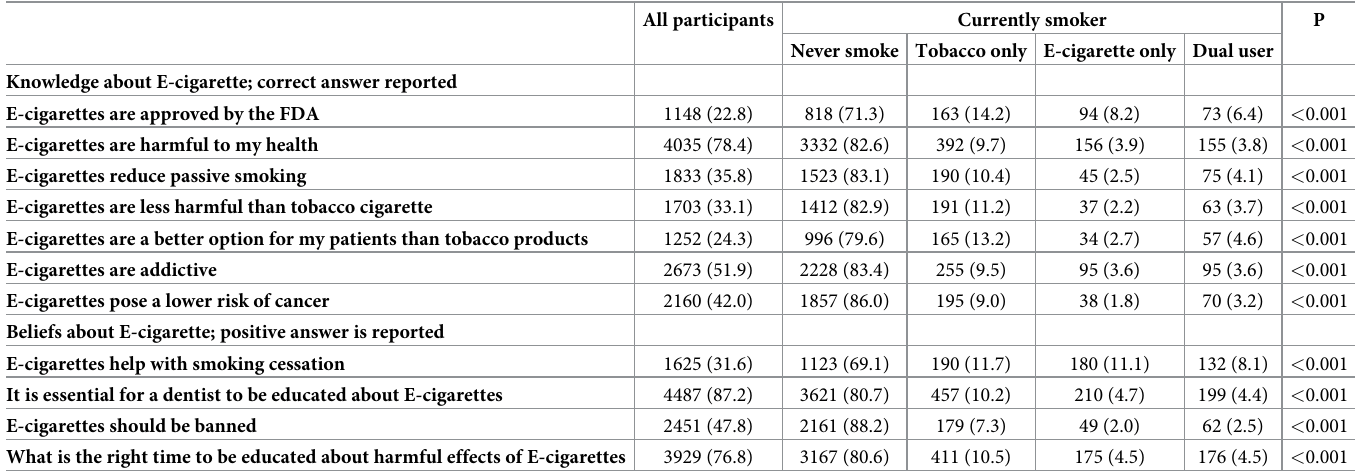
Table 2. Knowledge and beliefs about E-cigarettes (N = 5163).